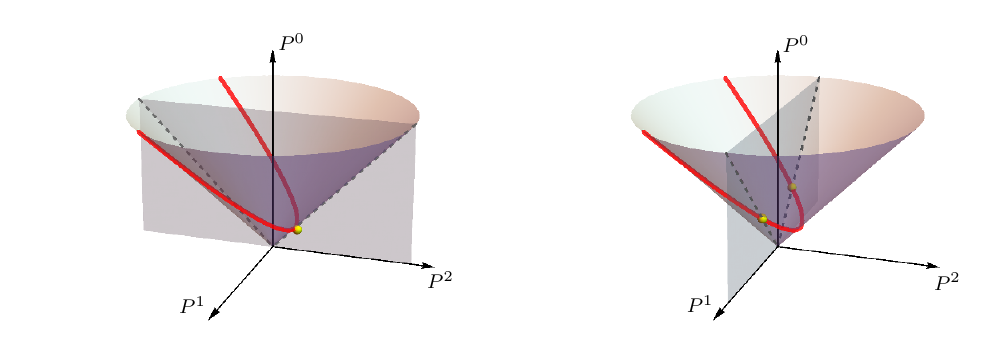
Figure 1 . Both pictures represent the example of a ( d + 2) = 3 dimensional embedding space, labelled by P M = ( P 0 ; P 1 ; P 2 ). We show the null cone, the defect plane and the Poincar(cid:19)e section (in red). In the left picture, the P (cid:0) axis lies on the defect plane. The latter intersects the Poincar(cid:19)e section in a single point (in yellow), which in physical space corresponds to a (cid:13)at defect. In the right picture, the P 1 direction is parallel to the defect plane, while P (cid:0) does not lie on it. The defect plane intersects the Poincar(cid:19)e section along P 1 in two points. This is a spherical defect centred in the